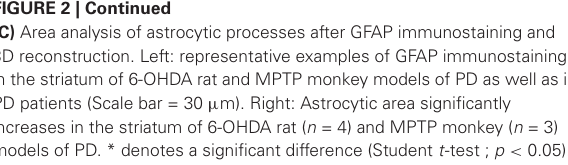
FIGURE 2 | Continued (C) Area analysis of astrocytic processes after GFAP immunostaining and 3D reconstruction. Left: representative examples of GFAP immunostaining in the striatum of 6-OHDA rat and MPTP monkey models of PD as well as in PD patients (Scale bar = 30 µ m). Right: Astrocytic area significantly increases in the striatum of 6-OHDA rat ( n = 4) and MPTP monkey ( n = 3) models of PD. * denotes a significant difference (Student t -test ; p <